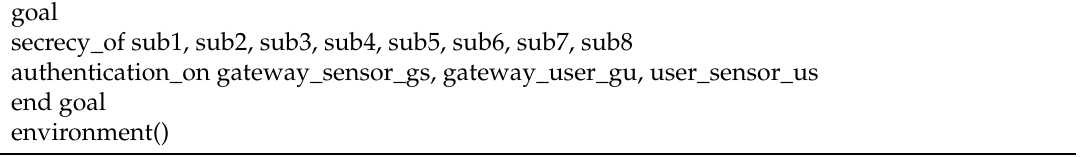
Table 19. Specification of proposed protocol’s goal in HLPSL.